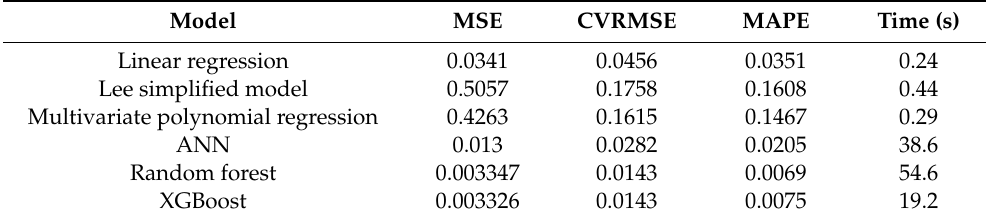
Table 4. Evaluation metrics of predict model for COP.